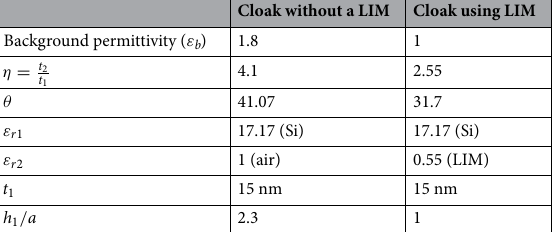
Cloak without a LIM Cloak using LIM Background permittivity ( ε b